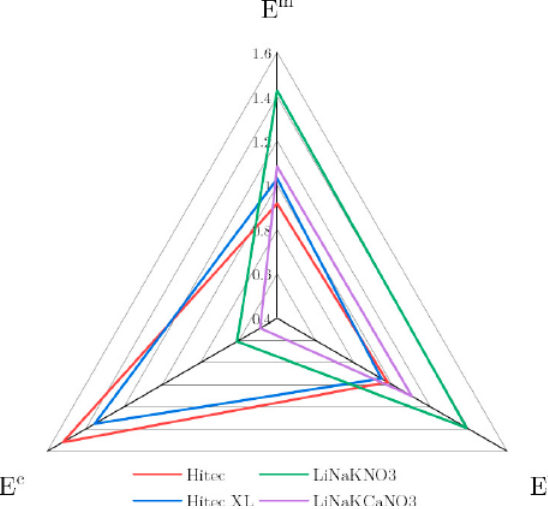
Figure 1. Nitrate-based TES materials KPIs comparison (Solar Salt = 1).